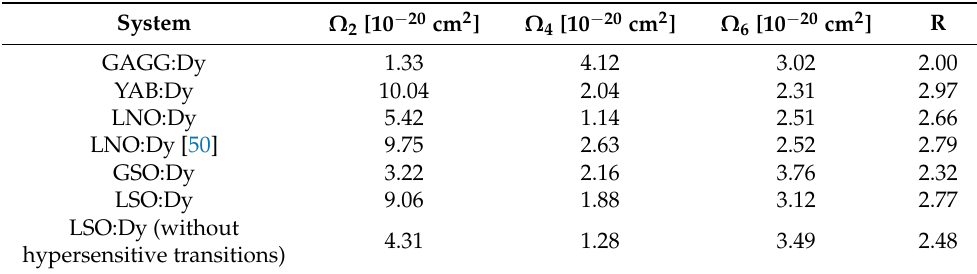
Table 5. The Judd–Ofelt Ω t parameters and calculated ratios R = A( 4 I 15/2 → 6 H 15/2 )/A( 4 F 9/2 → 6 H 15/2